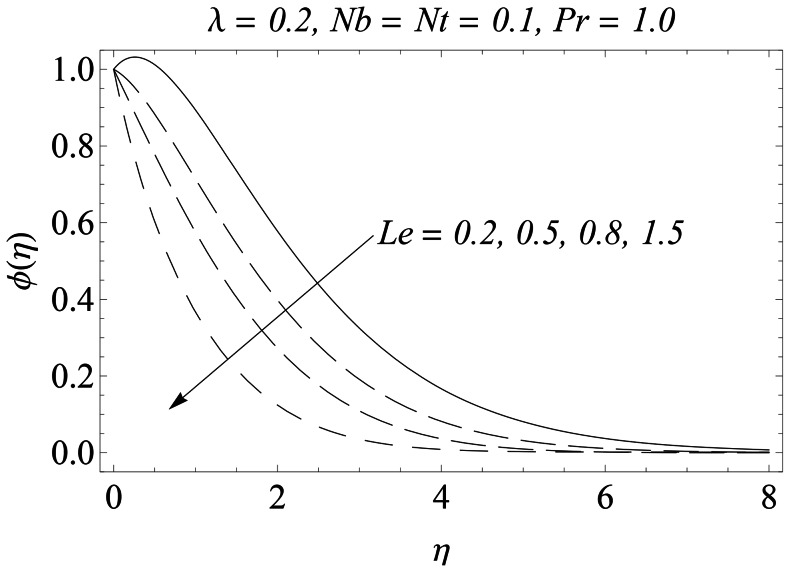
Influence of Le on .